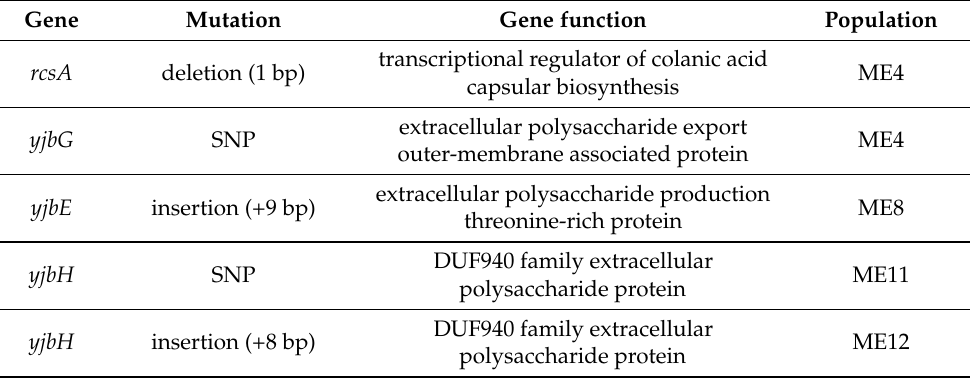
Table 1. Mutation candidates for causation of mucoidy in cycle 25 mucoid isolates from the four focal co-evolved